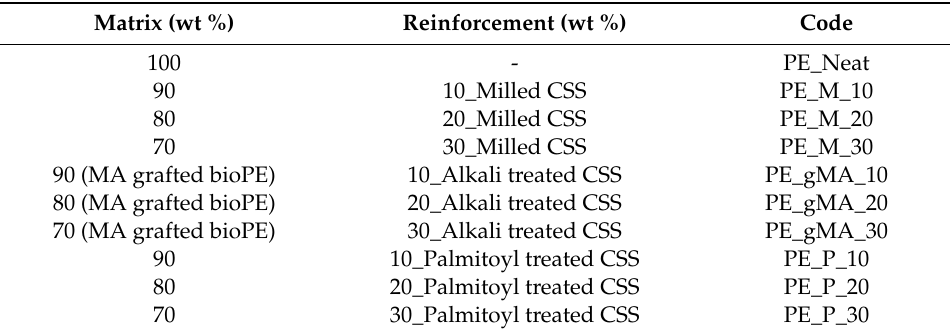
Table 3. Formulated composites